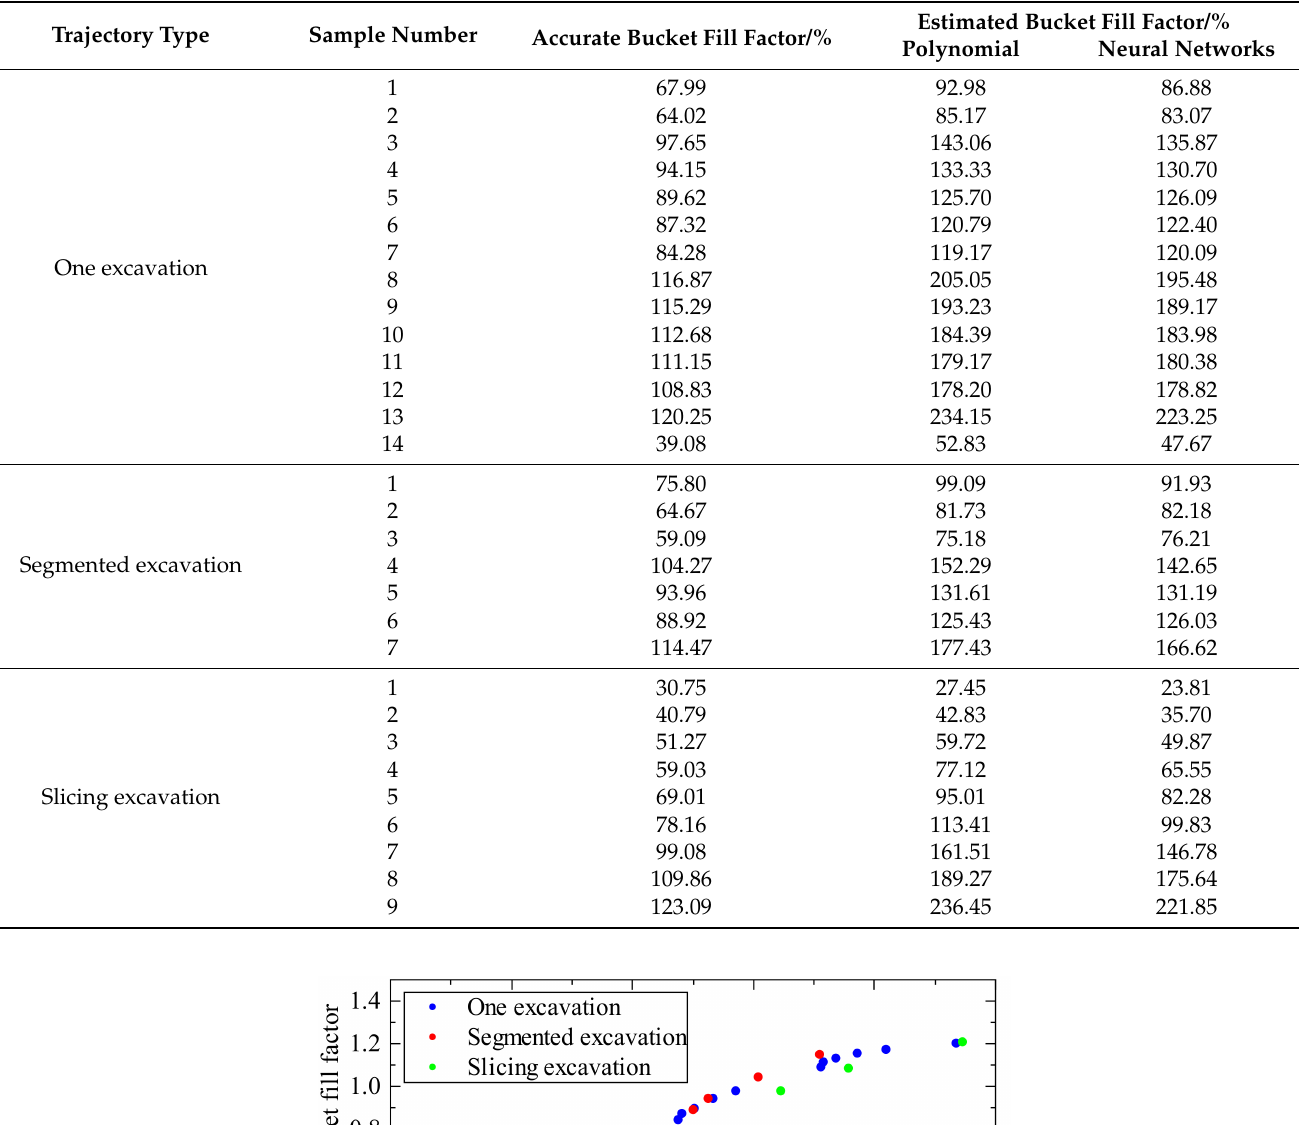
Table 4. Calculation results of estimated bucket fill factor.